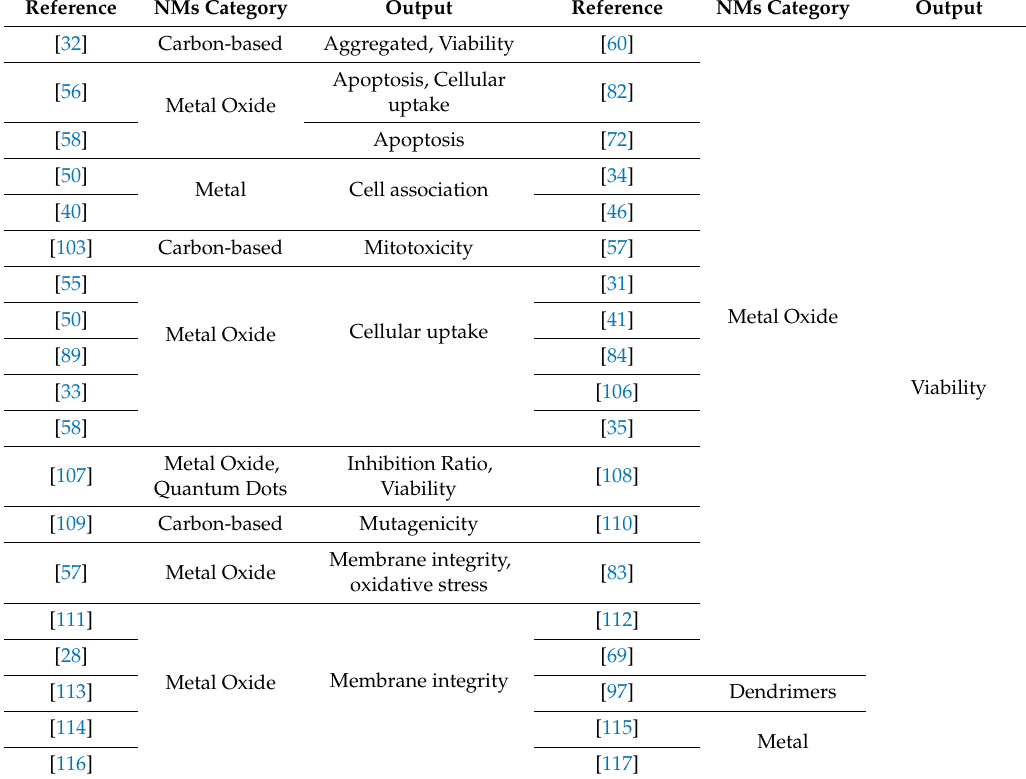
Table 4. Endpoints predicted by regression tools extracted from the studies